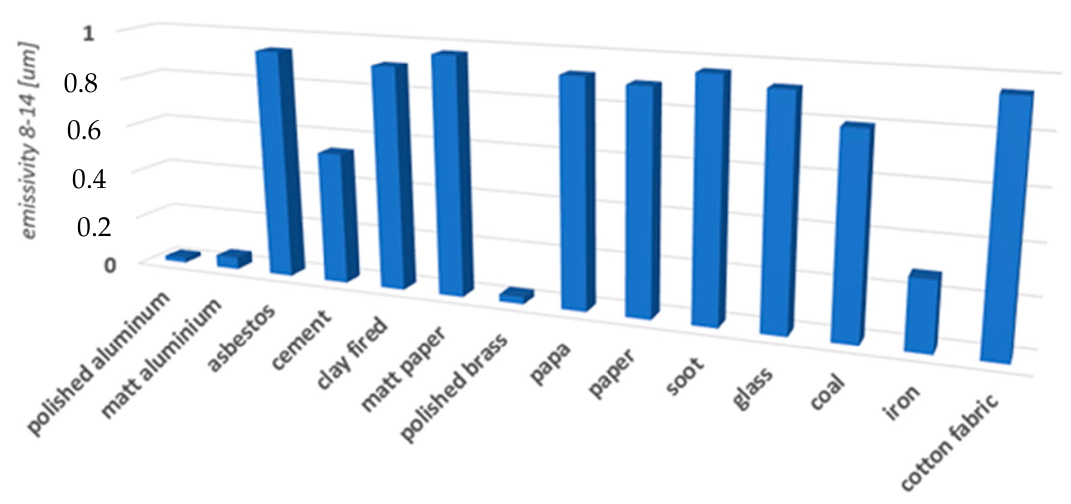
Figure 4. Table of emissivity of selected materials (8–14 μ m).